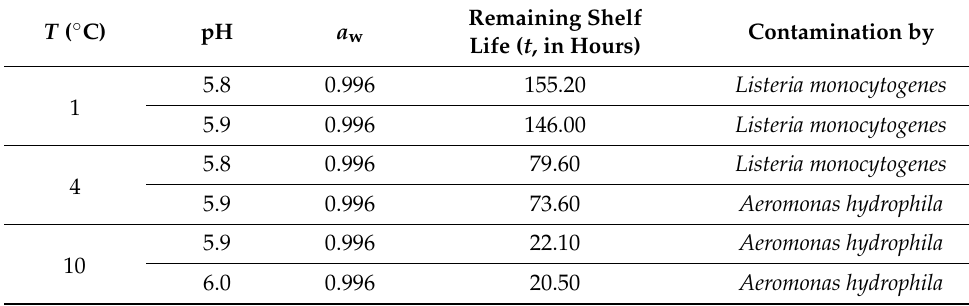
Table 6. Sampling of results of DSS—Remaining shelf life of